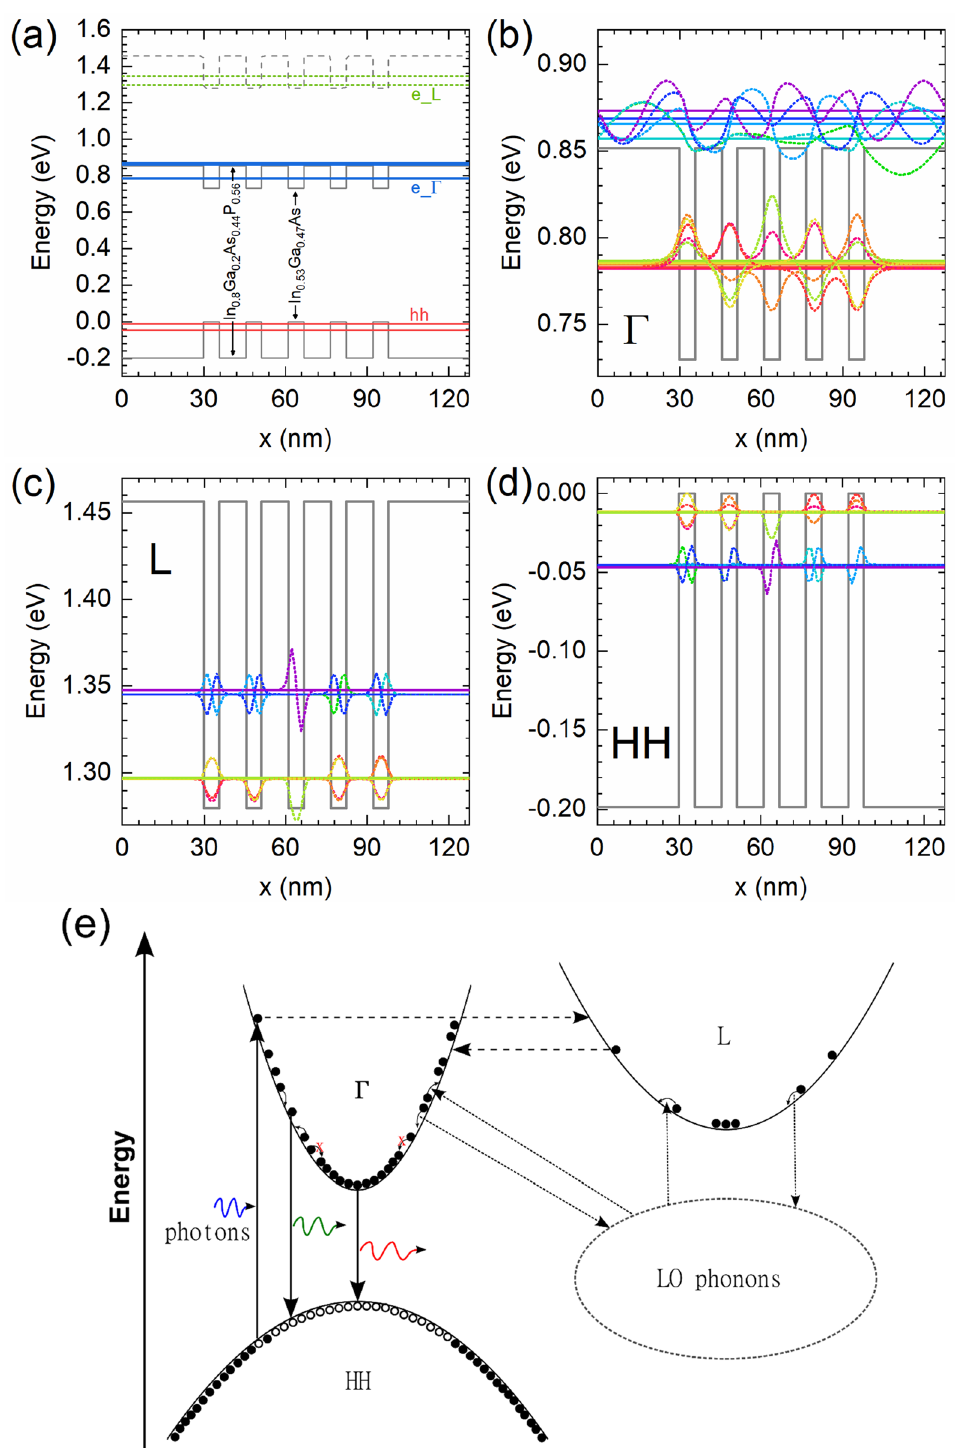
Figure 2. The ensemble Monte Carlo simulation space and mechanisms. ( a ) The calculated energy levels for the MQW. For reference, the 405 nm and 980 nm excitations correspond to 3.062 eV and 1.265 eV, respectively. ( b )–( d ) show the energy levels (horizontal solid lines) and wavefunctions (dotted curves) of the subbands perpendicular to the layer interfaces for the electrons ( Ŵ and L) and heavy holes (HH). ( e ) The optical generation and recombination, electron-LO phonon interaction, and intervalley scattering processes included in the EMC